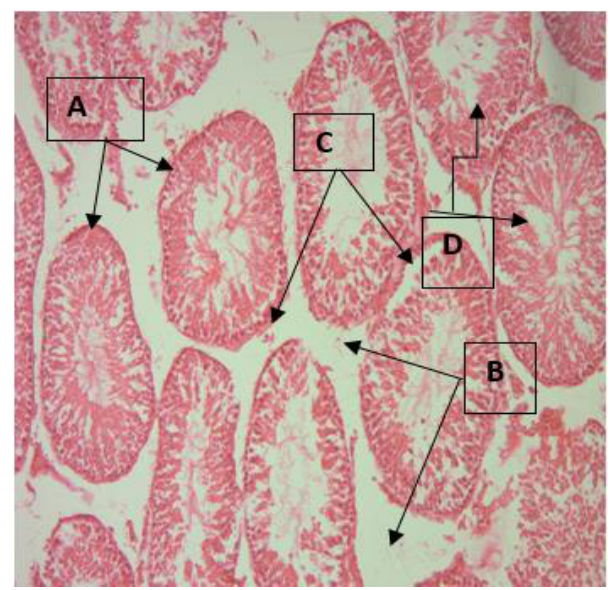
Fig. 1.6. Photomicrograph of testes showing thickened tunica albuginea Fig. 1.7. Photomicrograph of testis showing shrunken seminiferous (A) (Test group 400 X). tubules (A), wide and empty interstitial spaces (B), thickened basement membrane (C) and vacuolations (D) (Test group